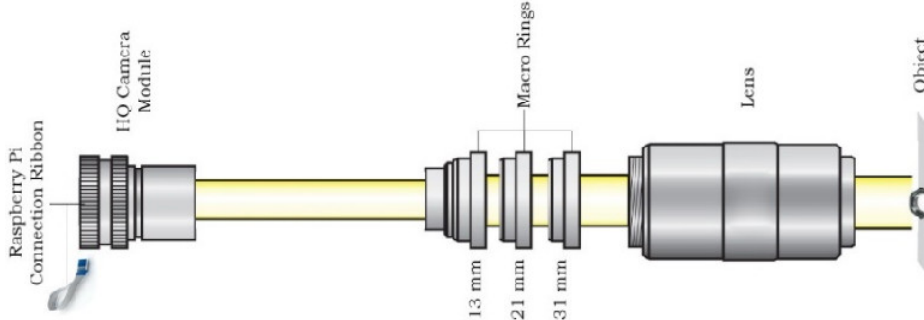
Figure 2. Information Process Cycle.